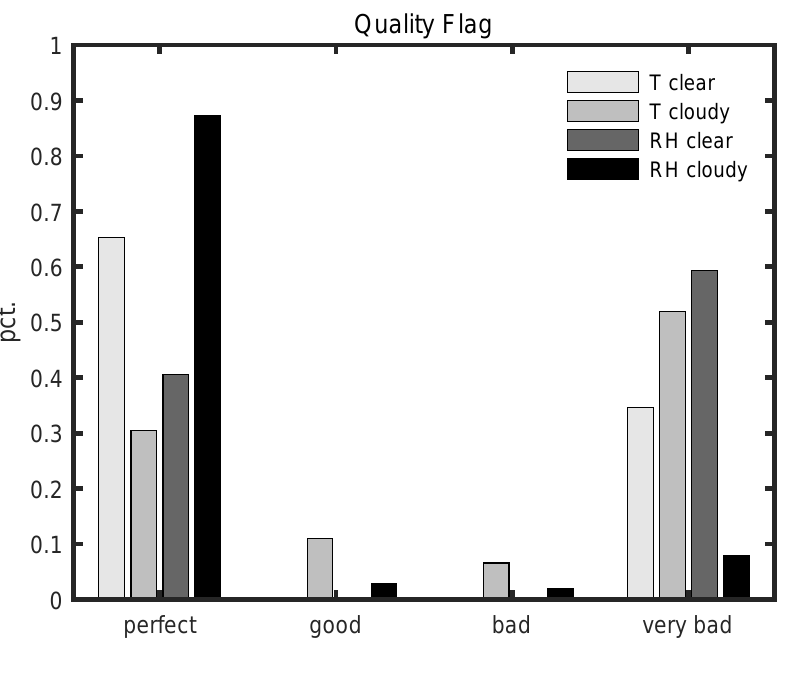
Figure 2. The percentages of the data quality flags. Based on 1.48 million profiles, the percentages of the data qualities are calculated for the temperature and humidity at the cloudy sky and clear sky separately. The light grey bars (or “T clear”) stand for the distribution of temperature quality under clear sky; the deep grey bars (or “T cloudy”) stand for the distribution of temperature quality under cloudy sky; the light dark bars (or “RH clear”) stand for the distribution of relative humidity data quality under clear sky; the deep dark bars (or “RH cloudy”) stand for the distribution of relative humidity quality under cloudy sky. The cloud masks are from the FY4A cloud product. The qualities flags are from the FY4A data products. Percentages are calculated through the ratio of the number in sub-category to the total case